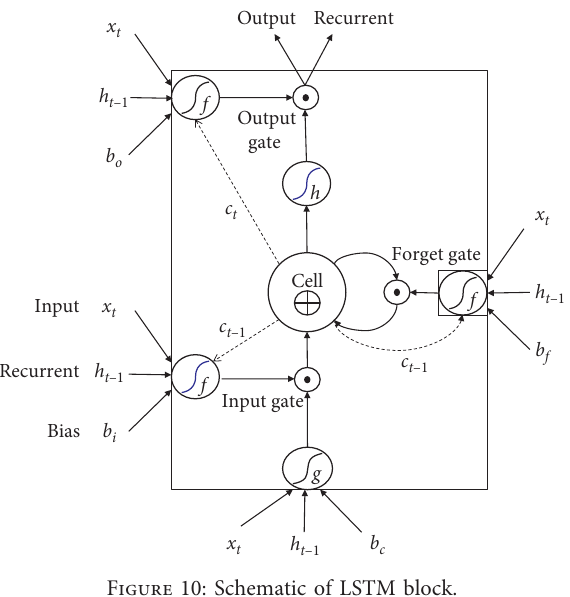
Figure 10: Schematic of LSTM block.